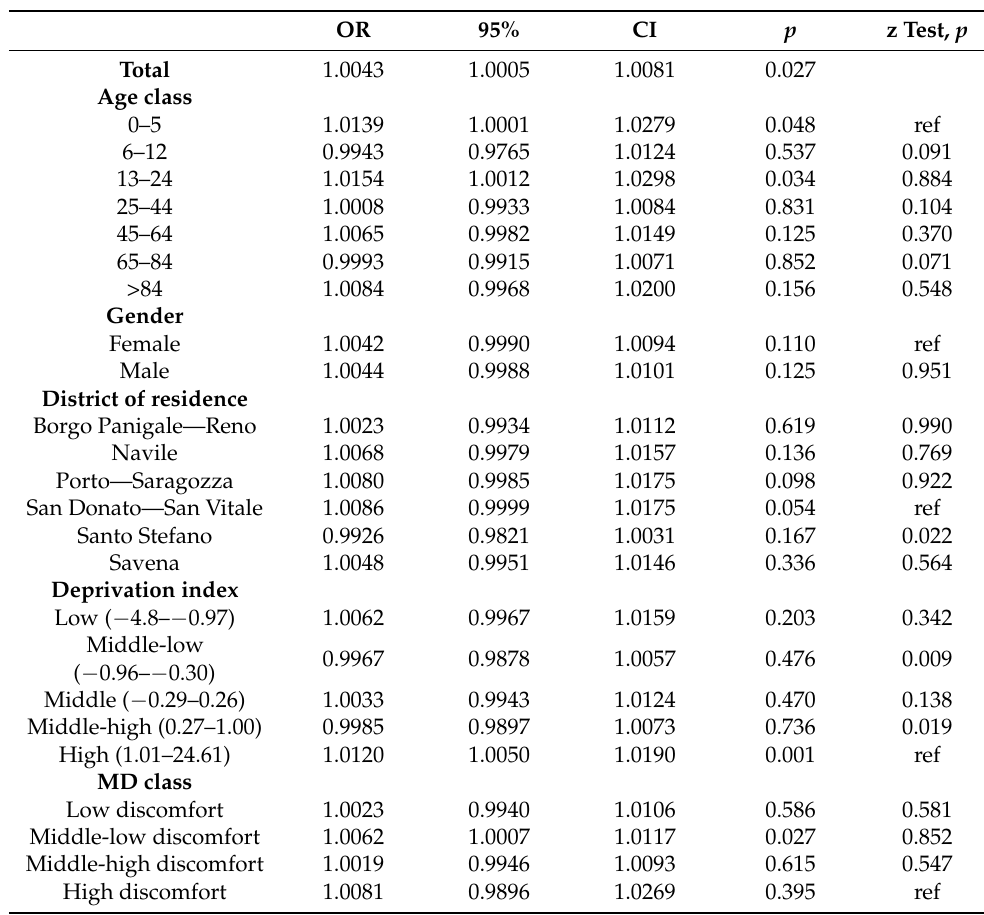
Table 3. OR (odds ratio) of EDV per 1 ◦ C increase above 26 ◦ C in mean apparent temperature (lag 0–1) and 95% confidence interval (CI) in the study populations according to demographic characteristics and microclimatic class and p value of the z